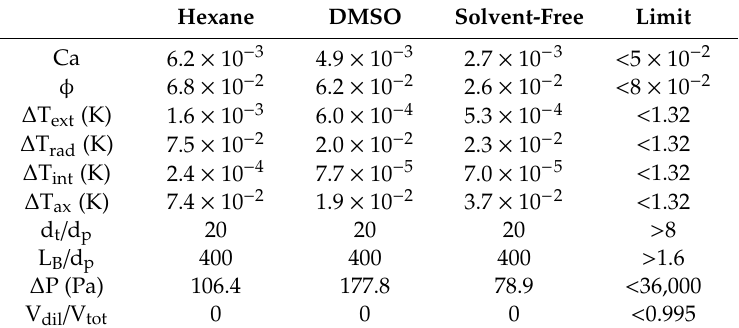
Table 3. Criteria for measuring intrinsic kinetics using a secondary methylaminopropyl (MAP)- functionalized mesoporous silica catalyst in the aldol reaction between acetone and 4-nitrobenzaldehyde